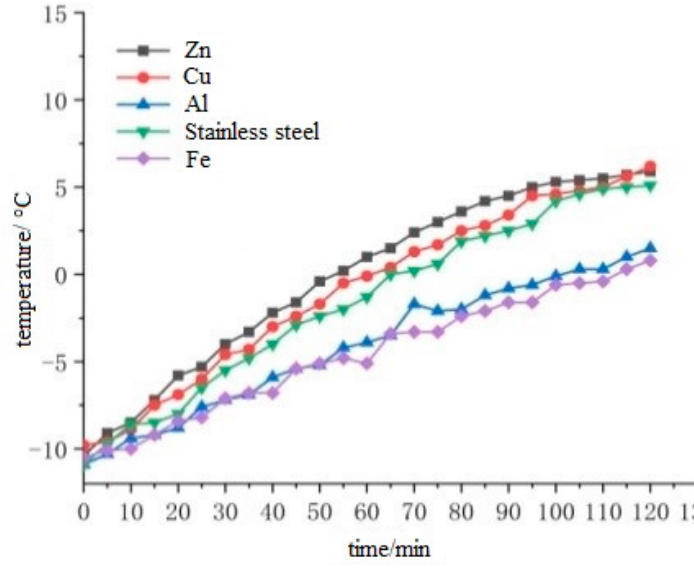
Figure 6. Diagram of the influence of different electrode sheets on the heating rate.